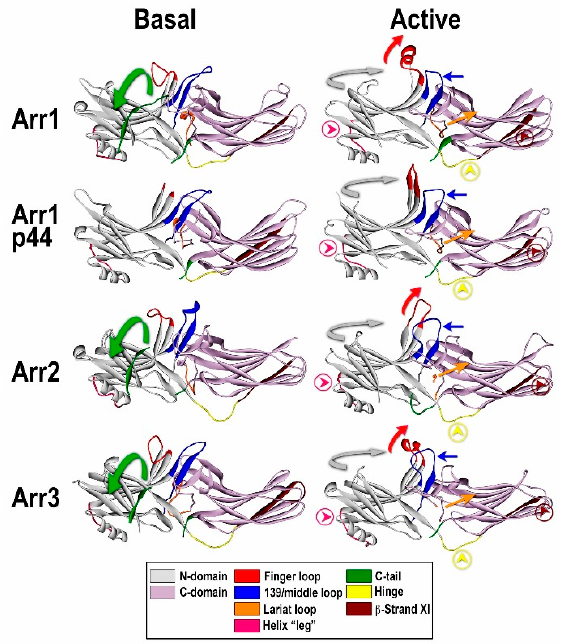
Figure 2. Comparison of the basal and “active” conformations of arrestin proteins. Crystal structures of arrestin-1 (Arr1) (PDB ID 1CF1) ( left ) [51] and 4ZWJ ( right ) [8], arrestin-2 (Arr2) (PDB ID 1G4M) ( left ) [50] and 4JQI ( right ) [63], short splice variant of arrestin-1, p44 (PDB ID 3UGU) ( left ) [65] and 4J2Q ( right ) [66], and arrestin-3 (PDB ID 3P2D) ( left ) [53] and (PDB ID 5TV1) ( right ) [67]. The elements with different conformations in active and inactive arrestins are shown, as follows: the C-tail, green (moves out of its basal position in the cavity of the N-domain in the process of receptor binding; absent in p44); inter-domain hinge, light blue (has essentially the same conformation in all activated arrestin structures, in contrast to a wide range of conformations in the basal state); β -strand XI, dark blue (it is register shifted by one residue in arrestin-2 and -3, which “flips” it by 180 degrees, and by two residues in arrestin-1 and p44, which moves it relative to the other parts of the molecule but does not change the exposed side chains); finger loop, red (moves towards the receptor, the tip becomes α -helical); 139-loop (also known as middle loop), violet (moves towards the N-domain); lariat loop extension, magenta (moves lariat loop towards the N-domain, out of its basal position, which removes two out of three negative charges from the polar core); the connector of the α -helix in the N-domain, pink. The twist of the two domains relative to each other (N-domain, teal; C-domain, gray) by 17–20 degrees is indicated by arrows.